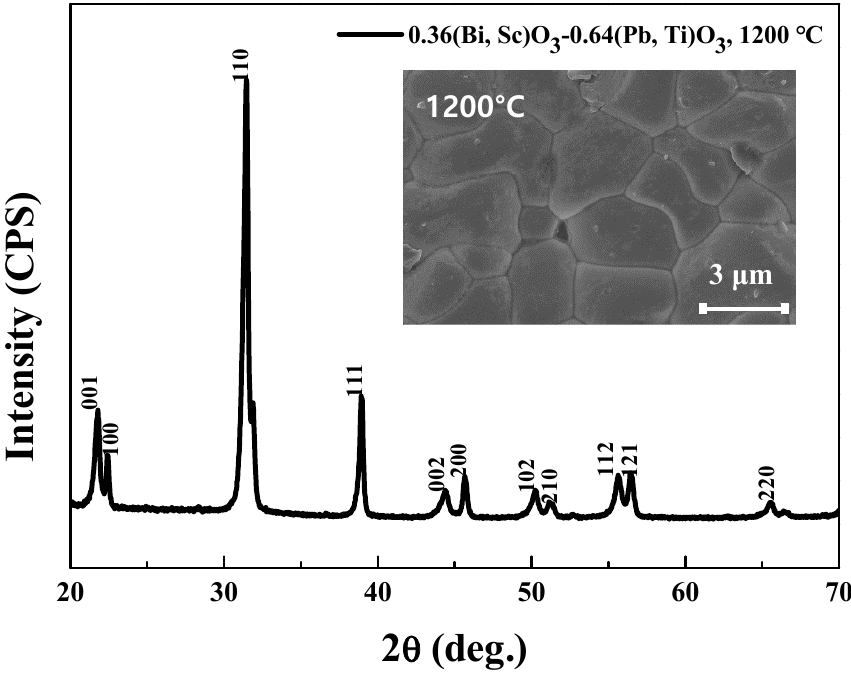
Figure 3. X-ray diffraction pattern data for the BS-PT piezoelectric ceramics sintered at 1200 ° C. Inset shows the field emission scanning electron microscopy (FE-SEM) images of the BS-PT piezoelectric ceramics.